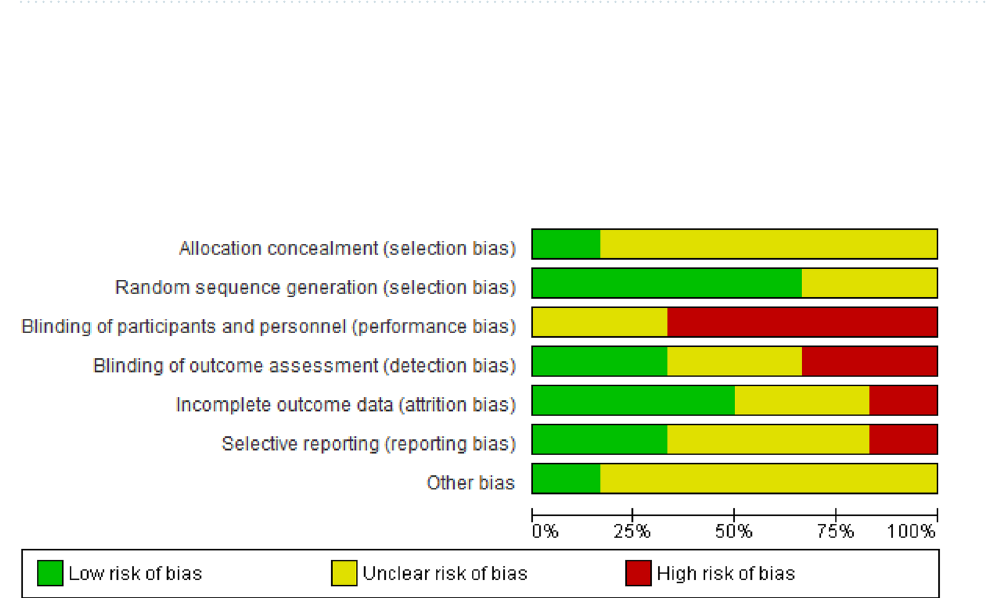
Figure 2. Risk of bias summary: review authors’ judgments on each risk of bias item for each included study. Revman 5. https:// train ing. cochr ane. org/ online- learn ing/ core- softw are- cochr ane- revie ws/ revman.